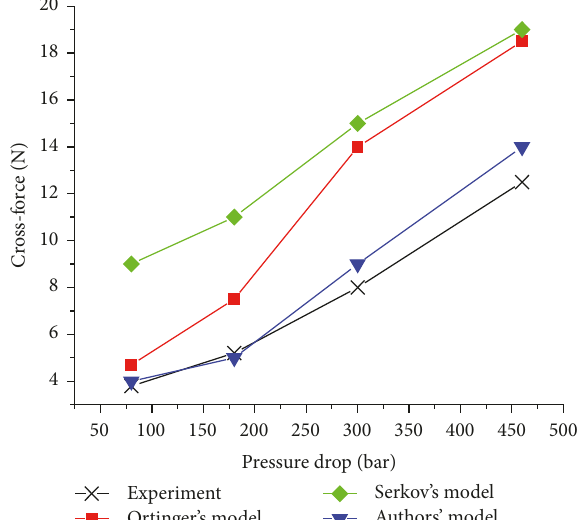
Figure 24: Comparison between the cross-forces evaluated experimentally and those predicted by three different bulk-flow models.